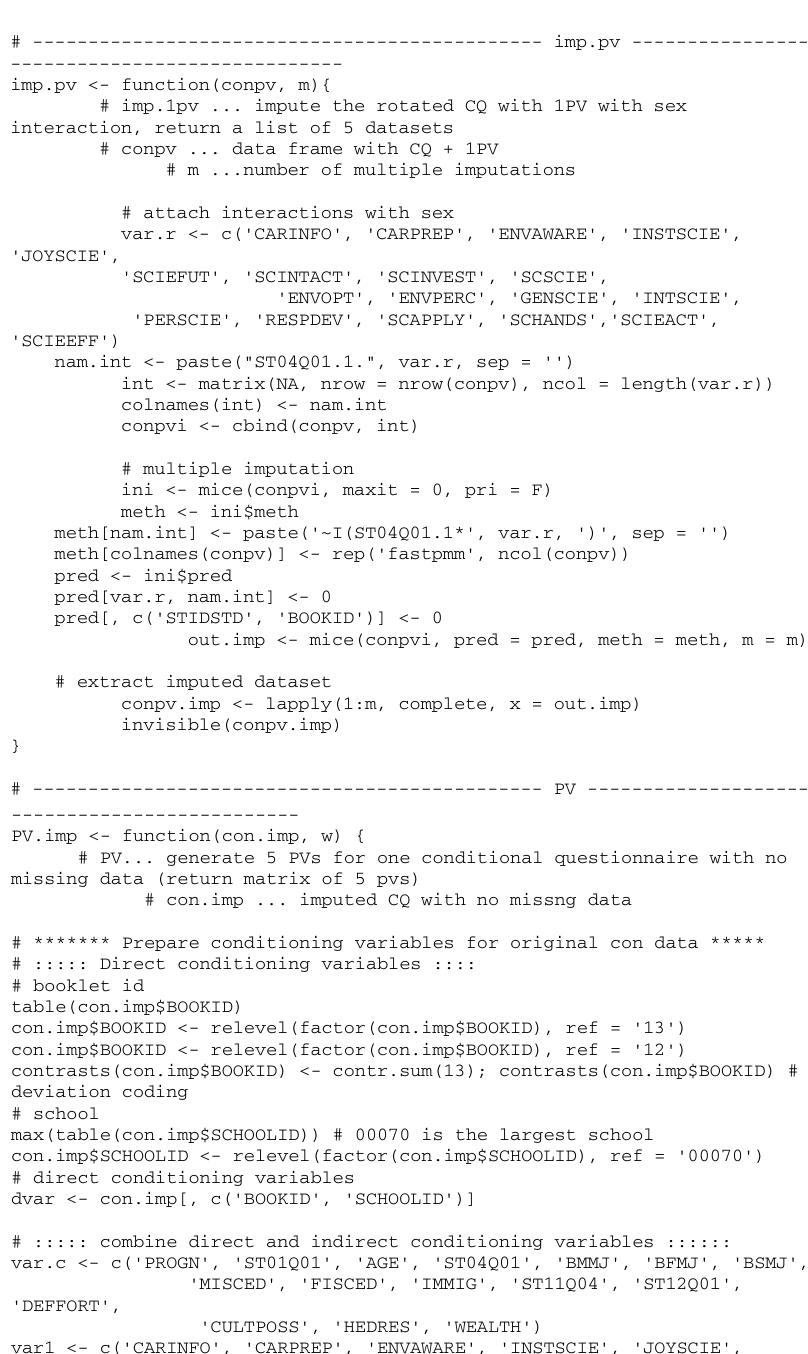
con.imp$BOOKID <- relevel(factor(con.imp$BOOKID), ref = '13') con.imp$BOOKID <- relevel(factor(con.imp$BOOKID), ref = '12') contrasts(con.imp$BOOKID) <- contr.sum(13); contrasts(con.imp$BOOKID) # deviation